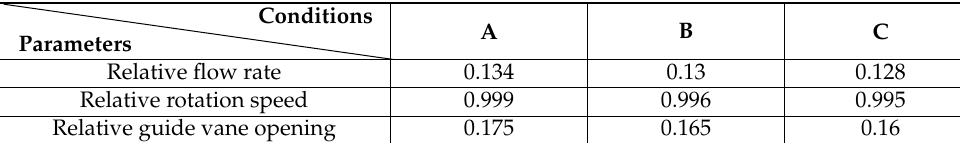
Table 1. The operating parameters of the three working conditions. Parameters